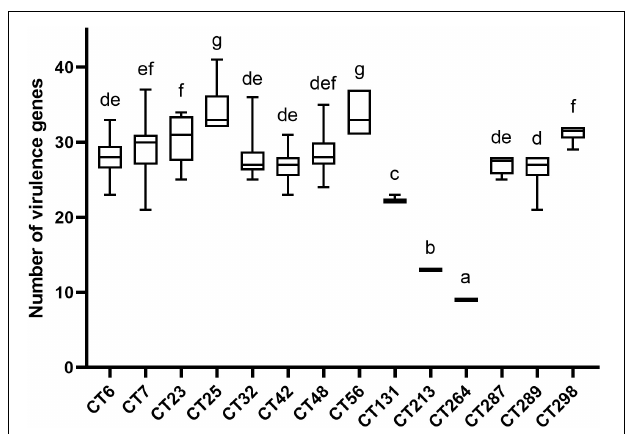
FIGURE 4 | Number of virulence genes among different CRISPR types of DEC strains. The same letter in the figure indicates that there is no significant difference between each other, and the absence of the same letter indicates that there is a significant difference between each other ( p < 0.01).